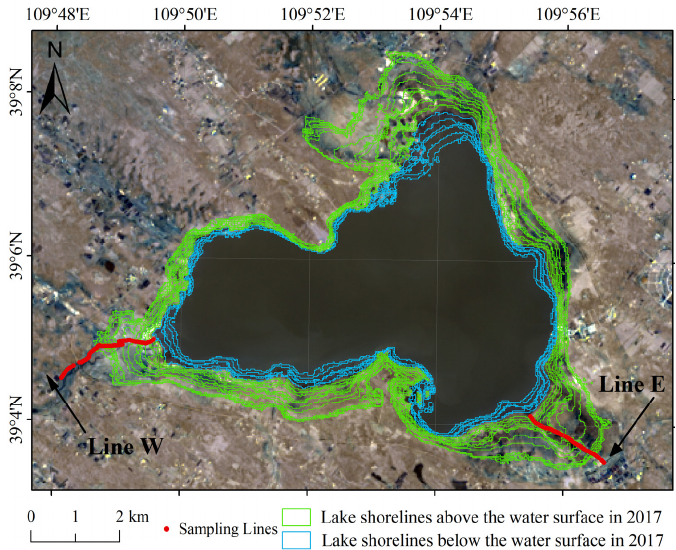
Figure 3. Spatial distribution of real-time kinematic sampling lines.